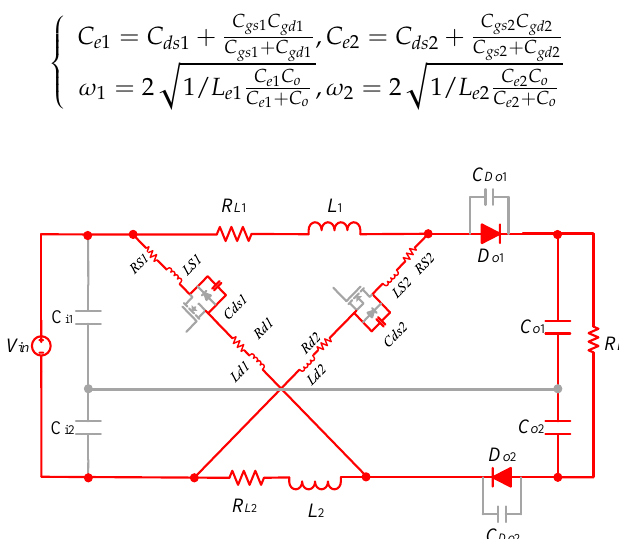
Figure 6. Equivalent circuit of Mode 3.